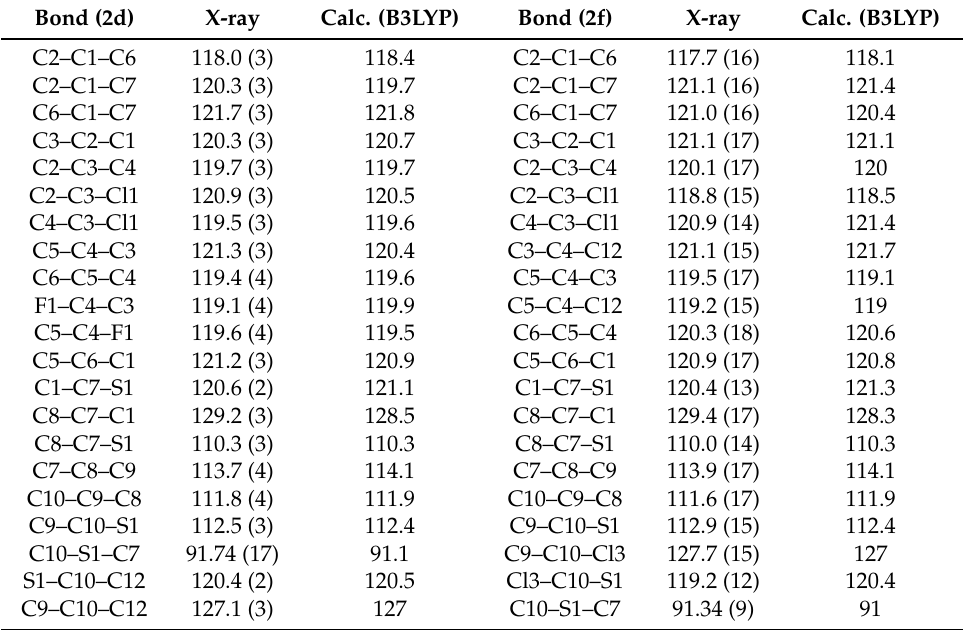
Table 3. Some selected X-ray and simulated bond angles ( ˝ ) of 2d and 2f (atomic labels are with Reference to Figure